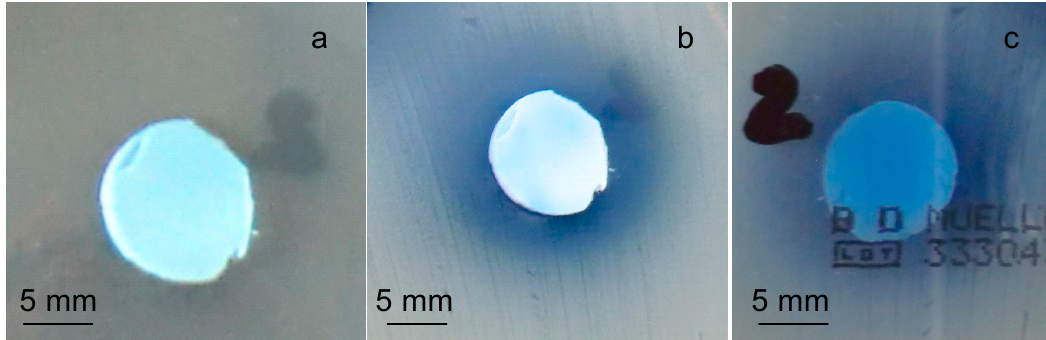
Figure 5. Inhibition halo of SBA2 glass ion exchanged in copper(II) acetate 0.01 M solution. ( a ) time zero; ( b ) front of the plate after 24 h of incubation; and ( c ) back of the plate after 24 h of incubation.